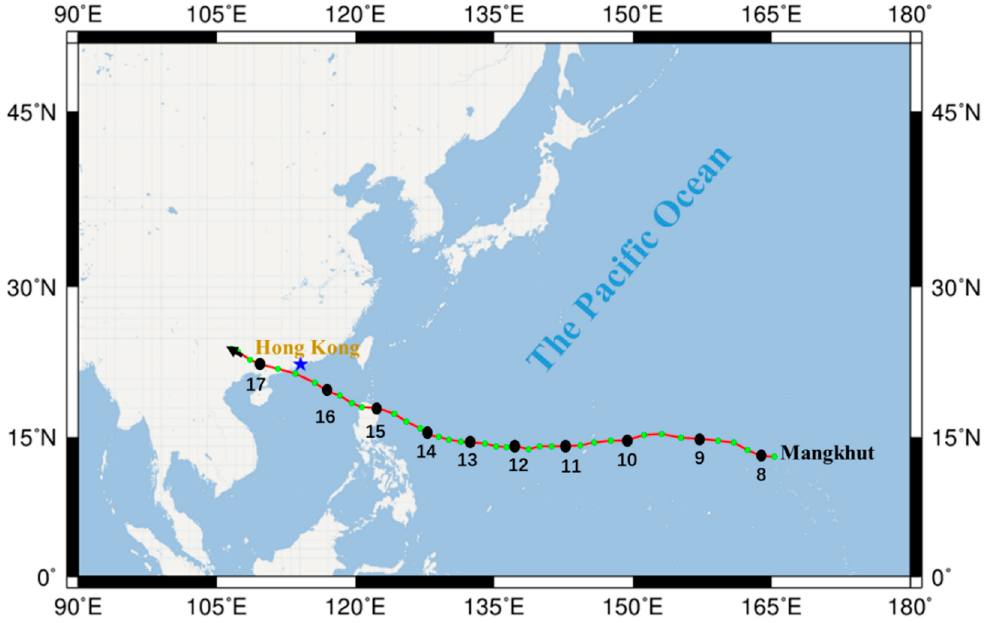
Figure 4. Trajectory of typhoon Mangkhut (every 6 h) during the period of 7–17 Sept.